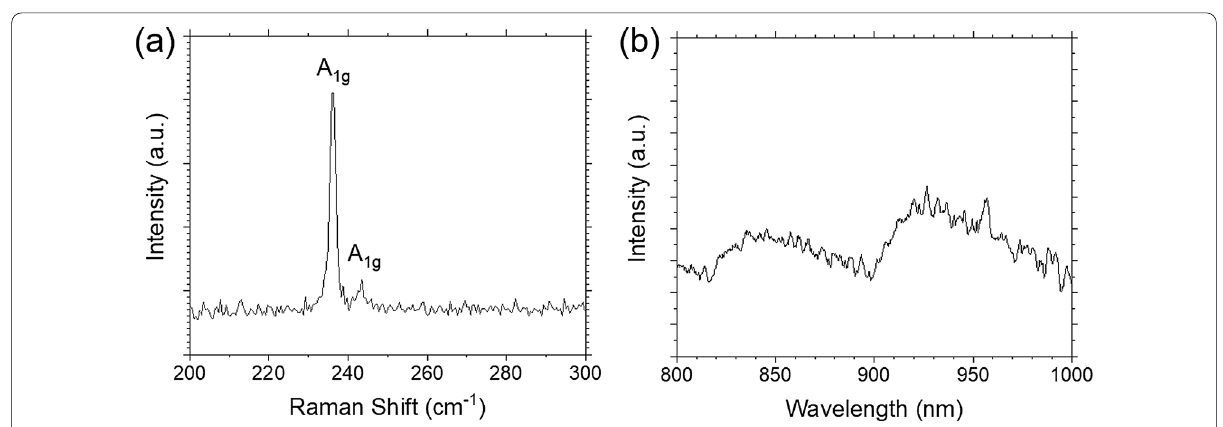
Fig. 4 a Raman and b PL spectra of MoSe 2 flake